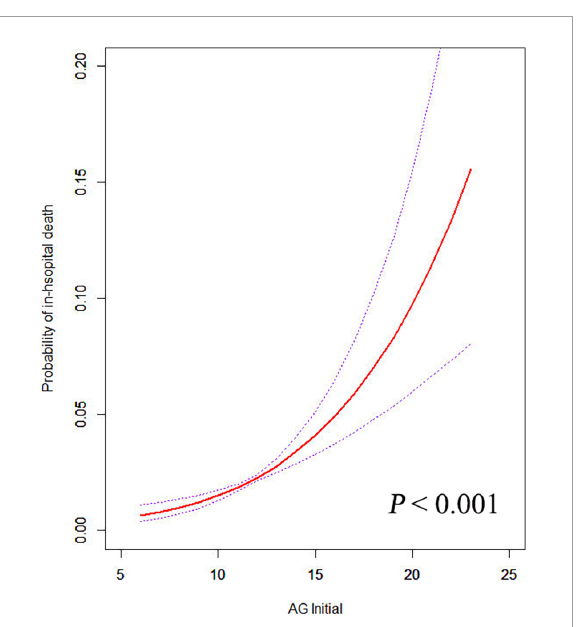
FIGURE2 The relationship between the initial AG and in-hospital mortality. A positive relationship between AG and the risk of in-hospital mortality was observed by the general additive model after adjusting for age, sex, ethnicity, BMI, insurance, hypertension, diabetes, congestive heart failure, stroke, COPD, kidney disease, liver disease, malignancy, type of surgery, SOFA score, SAPS II score, leukocyte, platelet, hemoglobin, creatinine, urea, PH, base excess, PO 2 , PCO 2 , glucose, heart rate, respiratory rate, MBP, temperature, and SPO 2